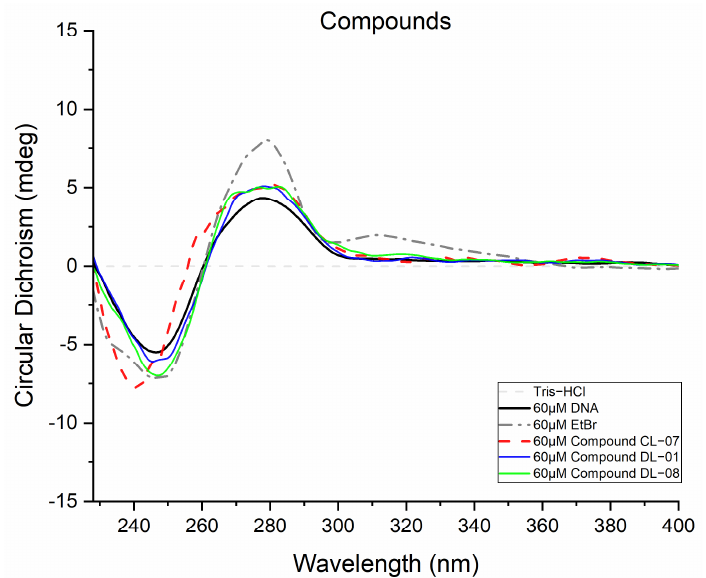
Figure 5. Circular dichroism of compounds and EtBr in the presence of CT DNA. Circular dichroism of DNA in the presence of acridine–thiosemicarbazone derivatives (60 µmol L − 1 ), in Tris − HCl buffer (pH 7.4).